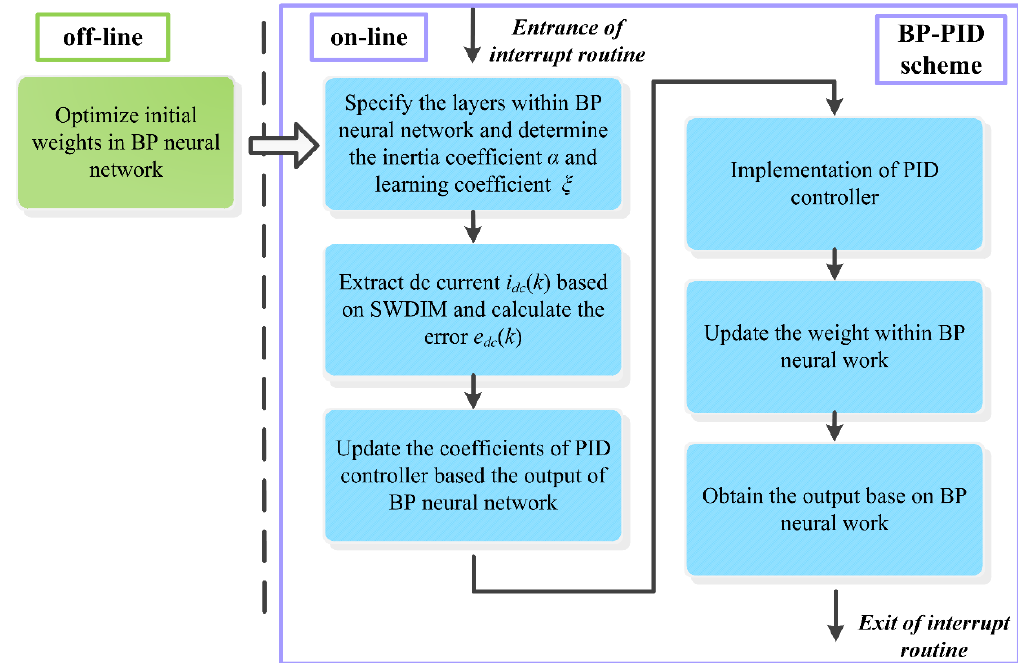
Figure 1. Flow chart of the genetic-algorithm-based back propagation neural network proportional–integral–derivative controller (GA-BP-PID) scheme for both the on-line and off-line regions. The BP-PID controller is only shown for the on-line region.